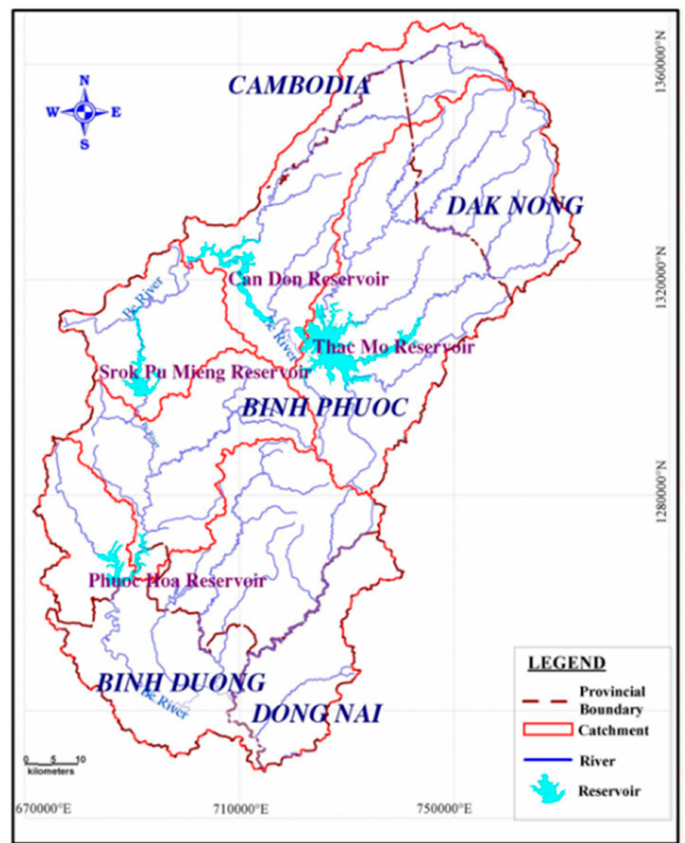
Figure 1. Location map of the Be River basin in